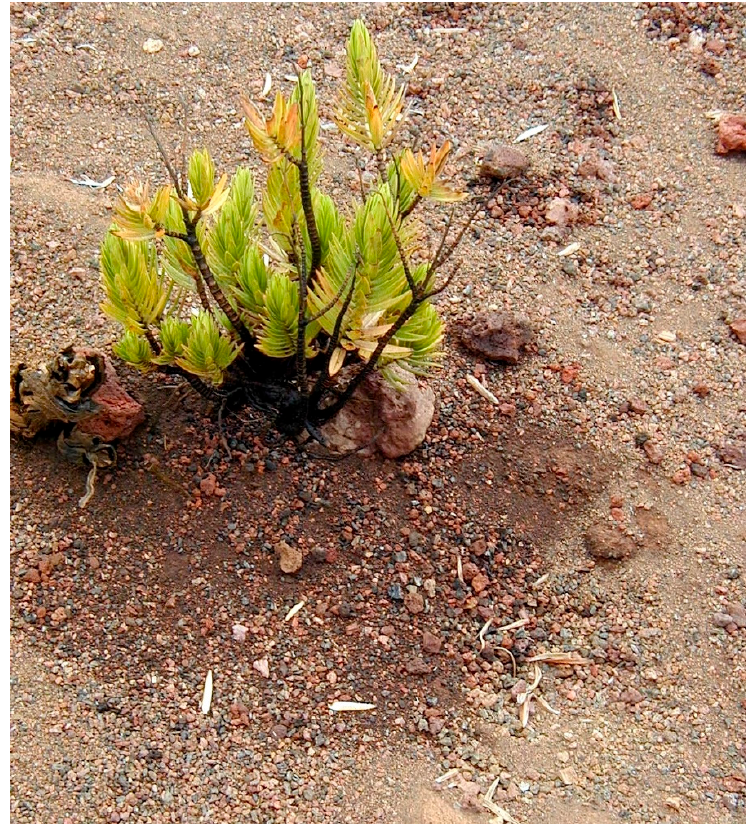
Figure 10. Small k ū paoa at ~2720 m on 12° slope, N 22° E aspect; the ~29-cm-high, ~30-cm-wide shrub intercepted moisture from incoming winds during 4–5 afternoon hours. The darker soil area downhill of plant faces prevailing trade winds and has accumulated fog-drip water along a ~20-cm-wide, 4–5-cm-deep band near shrub. Area shown is ~50 cm-wide; upslope is to the top. Photo: Hk-143-01, 29 July 2001.